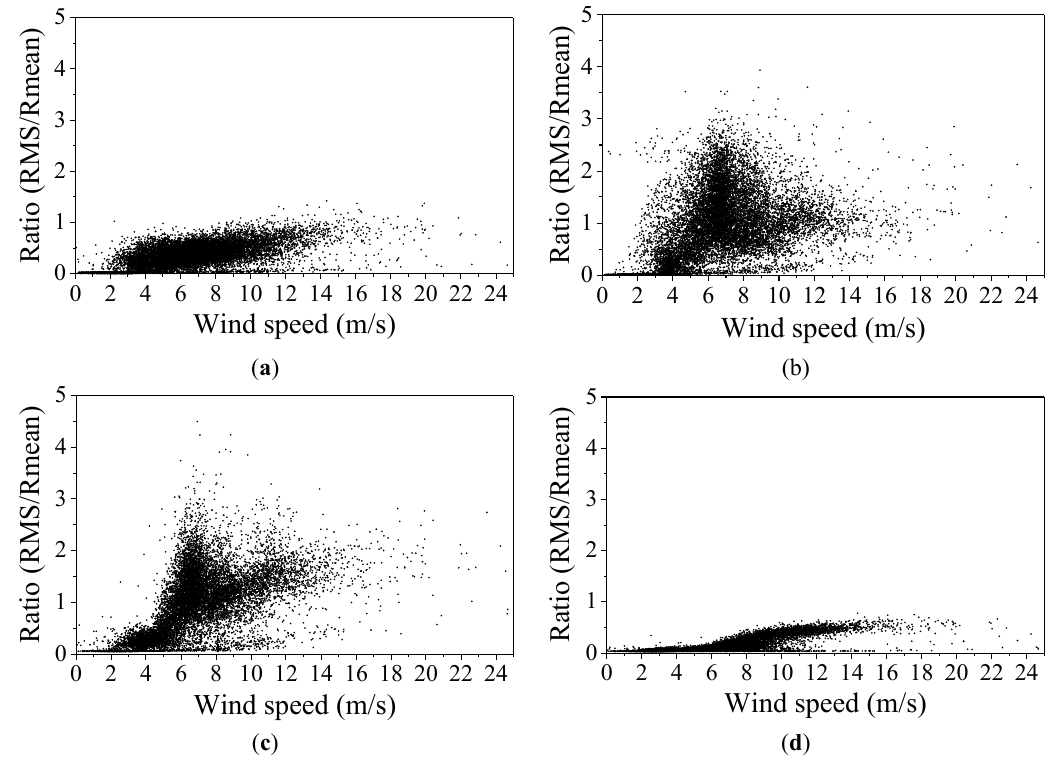
Figure 15. The ratio RMS/Rmean calculated by the strain and acceleration responses against the wind velocity. ( a ) The ratio RMS/Rmean calculated by the strain gauge S8 at the top of the tower; ( b ) the ratio RMS/Rmean calculated by the strain gauge S10 at the foot of the tower; ( c ) the ratio RMS/Rmean calculated by accelerometer Y2 at the top of the tower; ( d ) the ratio RMS/Rmean calculated by accelerometer Y8 at the foot of the tower.